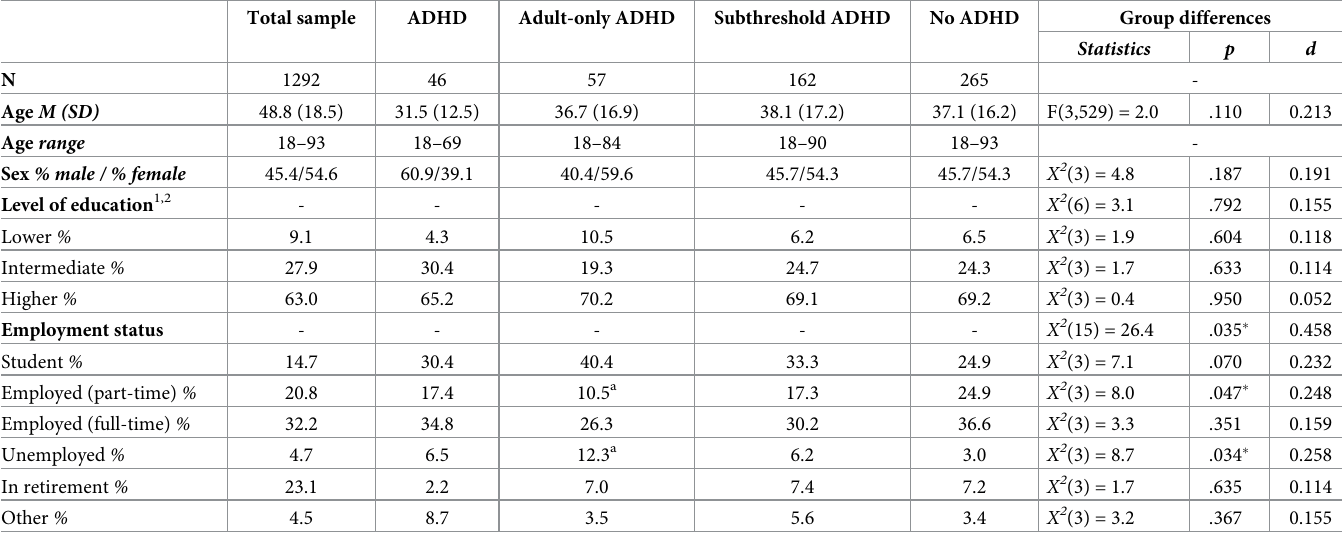
Table 1. Demographic characteristics of total sample and ADHD